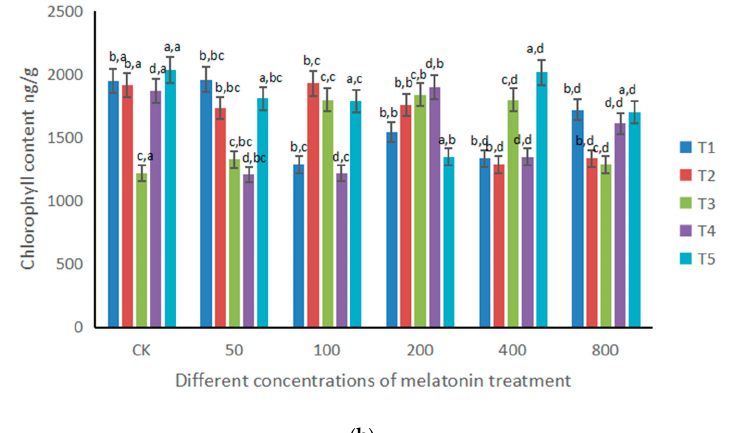
Figure 4. Relative MDA and chlorophyll content of Populus cathayana × canadansis ‘Xin lin 1’ leaves under control and different MT treatments based on salt and alkaline stress in different time periods of the experiment. T1 means 10 days, T2 means 14 days, T3 means 18 days, T4 means 22 days, T5 means 26 days. Each value is the average ± standard error ( ± SE). For two-way ANOVA, the letters on the left represent the detection phase ( p < 0.05) and the letters on the right represent the experimental concentrations ( p < 0.05). ( a ) Changes of MDA content, ( b ) changes of chlorophyll content.